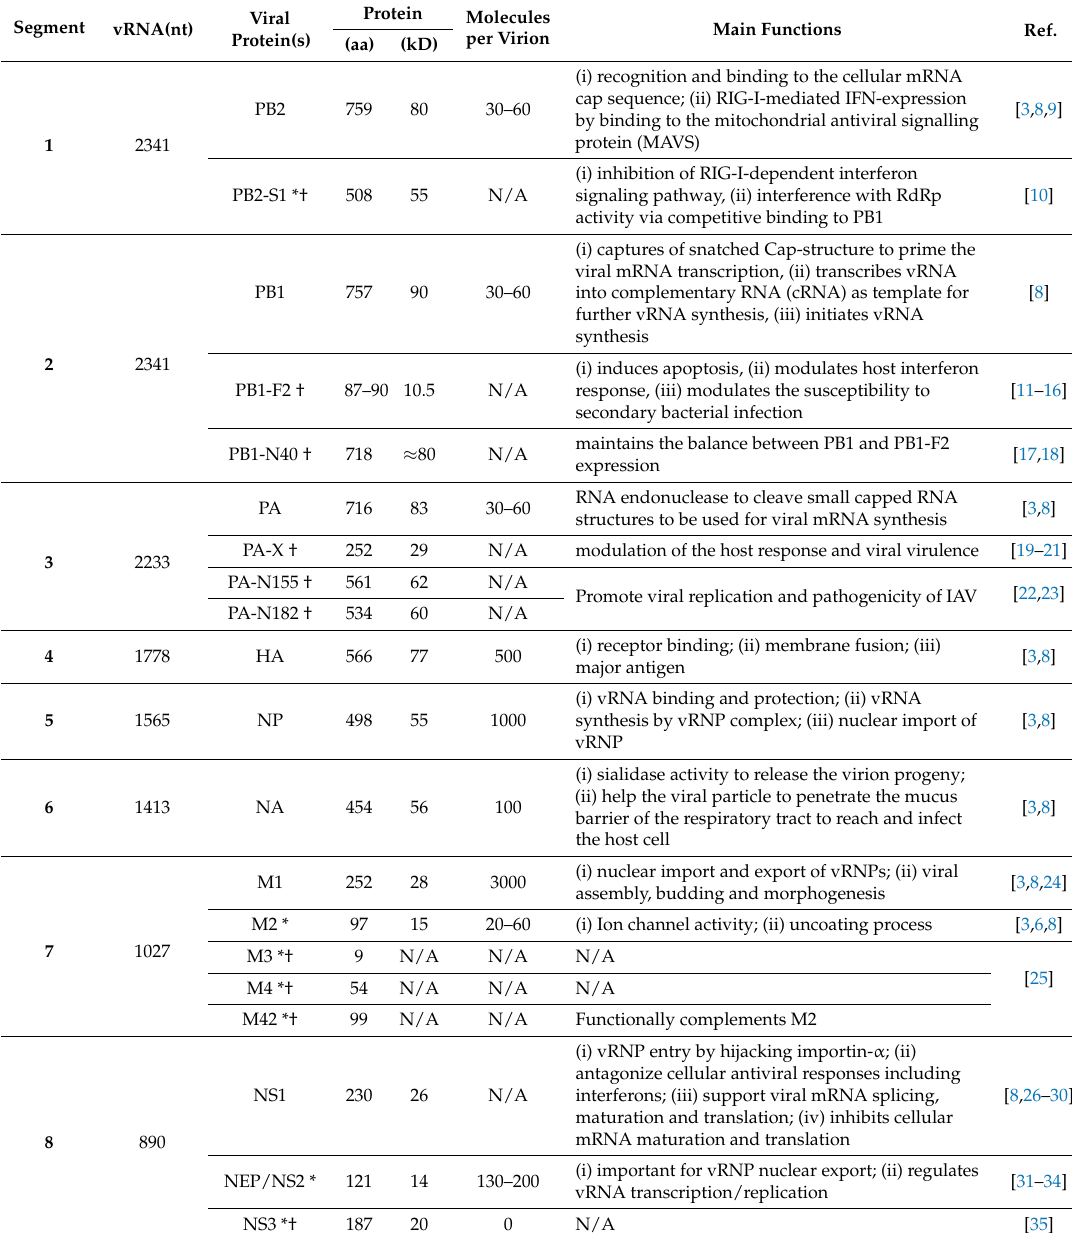
Table 1. The genome and functional proteins of influenza A virus